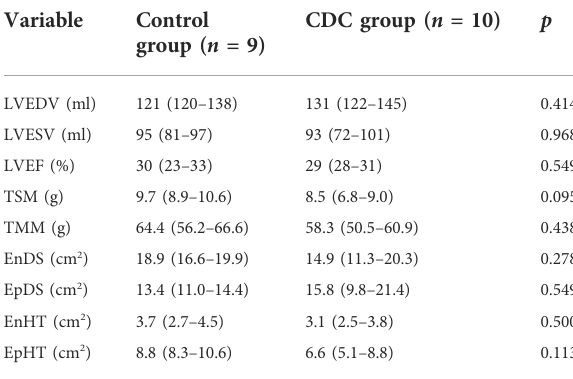
TABLE 1 Baseline characteristics of the treatment groups for the variables evaluated in the fi rst CMR. Shown are the median values of the variables and the p -value of the contrast of hypotheses (Mann- Whitney test). LVEDV: end-diastolic left ventricular volume. EnDS: endocardial dense scar. EnHT: endocardial heterogeneous tissue. EpDS: epicardial dense scar. EpHT: epicardial heterogeneous